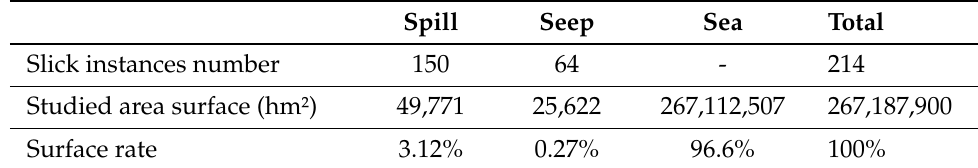
Table 4. Statistics of the test dataset.